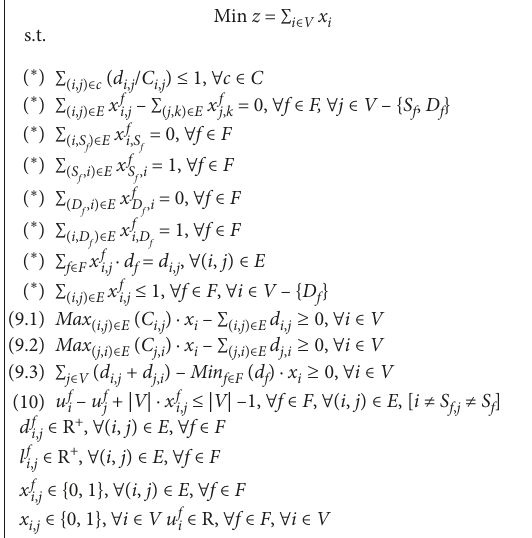
Figure 5: ILP formulation to minimize the number of used nodes when routing a set of